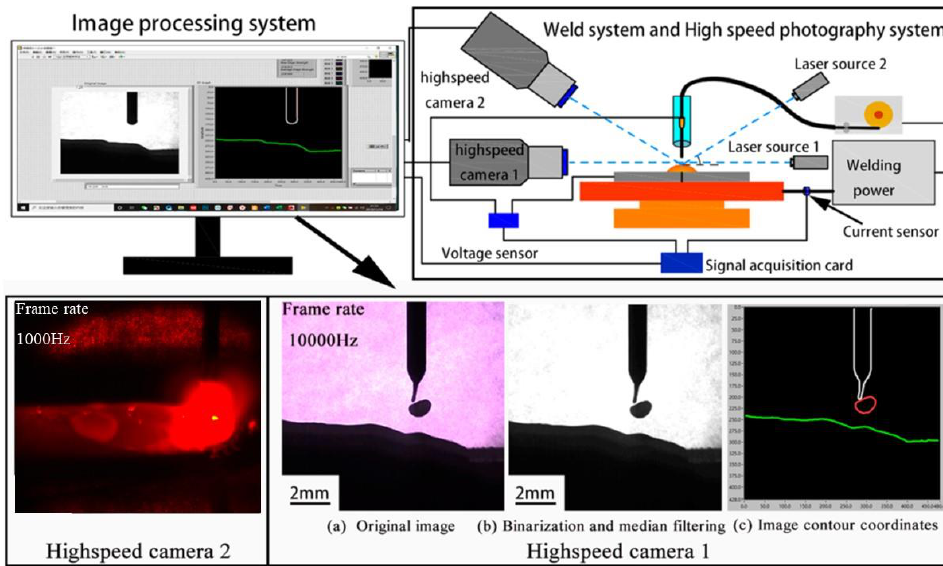
Figure 1. Experimental system and image processing system.